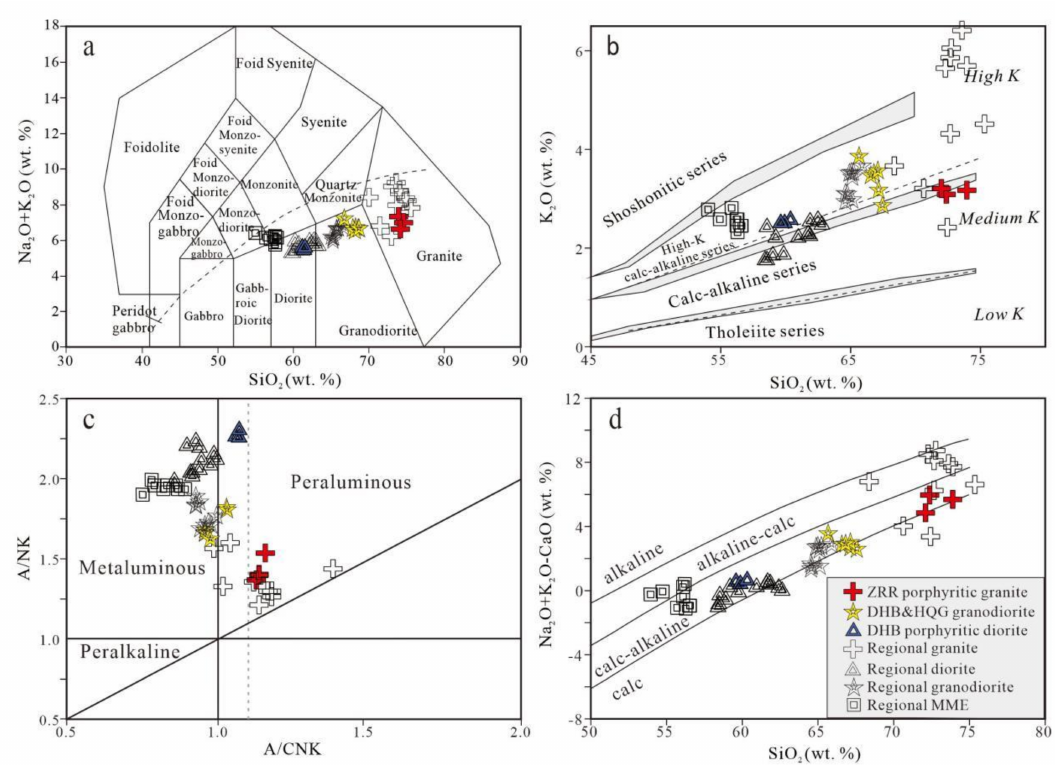
Figure 6. The geochemical classification for the intermediate-acid intrusive rocks in the Ela Mountain area. ( a ) Total alkali versus SiO 2 (TAS) diagram [22]; ( b ) SiO 2 versus K 2 O diagram [23] ( c ) A/NK ver- sus A/CNK diagram (A/NK = Al 2 O 3 /(Na 2 O + K 2 O) molar, A/CNK = Al 2 O 3 /(CaO + Na 2 O + K 2 O) molar [24]; ( d ) (Na 2 O + K 2 O − CaO) versus SiO 2 diagram [25]. Data sources: The data for Regional granite were from [1,4], and they indicate previous granites of the same period of the ZRR porphyritic granites (252–247 Ma) in the east section of the East Kunlun Orogenic Belt; the data for Regional granodiorite were from [2,5], and they indicate previous granodiorites of the same period of the DHB and HQG granodiorites (241–235 Ma) in the east section of the East Kunlun Orogenic Belt; the data for regional diorite were from [1–3], and they indicate previous diorites of the same period of the DHB porphyritic diorites (241–235 Ma) in the east section of the East Kunlun Orogenic Belt; the data for MME were from [2,5], and they indicate previous MMEs of the same period of the